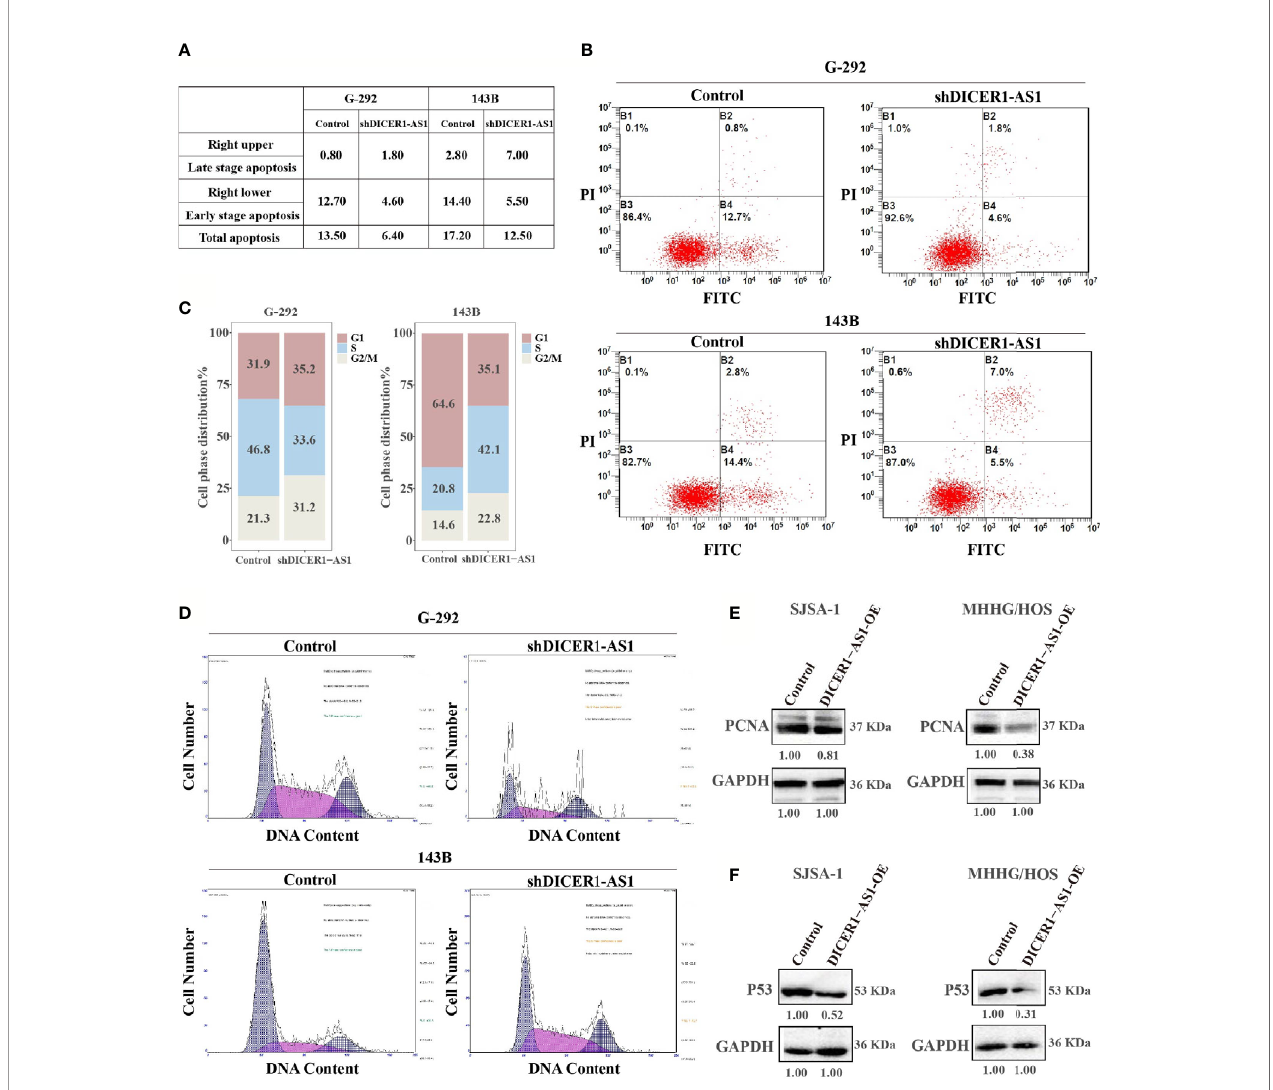
FIGURE 3 | DICER1-AS1 is involved in OS cells apoptosis and G2/M arrest. (A, B) The effects of the forced reversal of DICER1-AS1 level on the apoptosis of G- 292 and 143B cells by FACS analysis in plot and in the original with a graph of the analyzed data and plots of the original FACS data. (C, D) The effects of the forced reversal of DICER1-AS1 level on the cell cycle distribution of G-292 and 143B cells by FACS analysis in plot and in the original. (E) The protein levels of cell apoptosis related gene PCNA in SJSA-1 and MNNG/HOS cells infected with DICER1-AS1-OE versus the negative control(NC) determined by western blot analyses. (F) The protein levels of cell cycle related gene p53 in SJSA-1 and MNNG/HOS cells infected with DICER1-AS1-OE versus the negative control(NC) determined by western blot